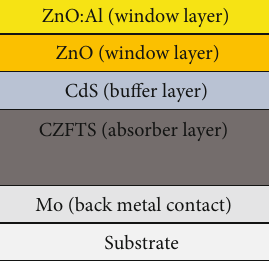
Figure 1: CZFTS solar cell structure used in this